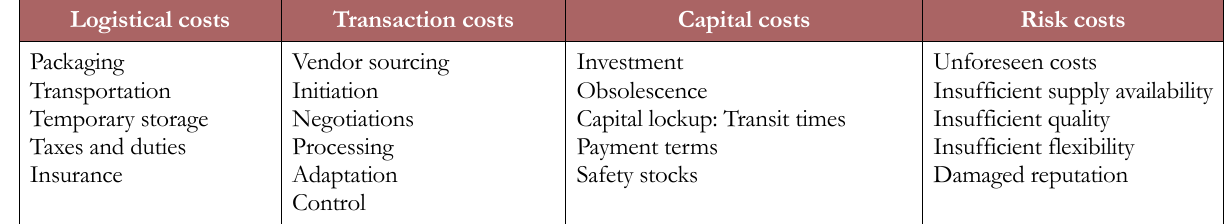
Table 3. Costs of global sourcing (Alard,